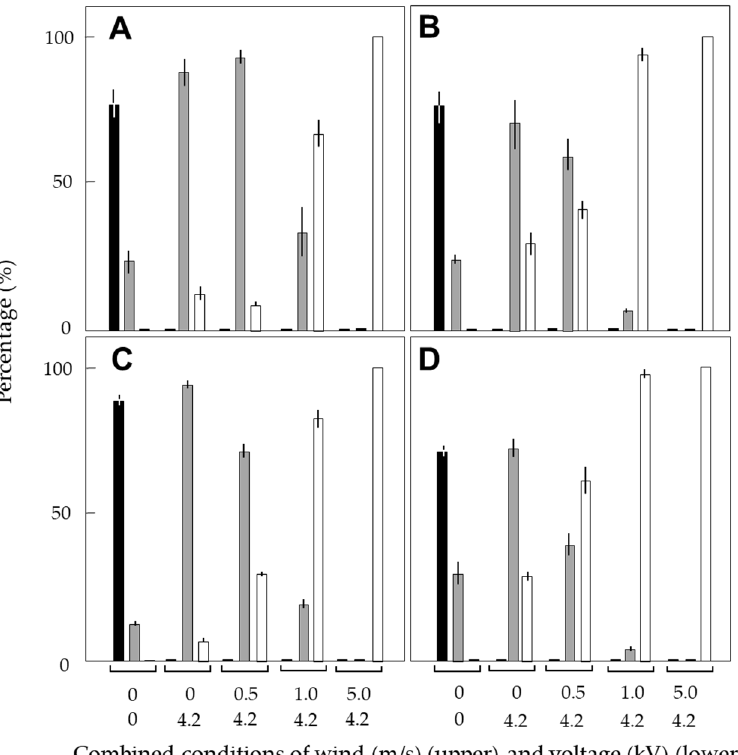
Figure 11. Behavior of adults of shore flies ( A ), western flower thrips ( B ), green peach aphids ( C ), and whiteflies ( D ) reaching the screen net under different wind speed and voltage conditions. Black, gray, and white columns represent insects passing through the screen, removed without entering the screen, and drawn to the NC-IC, respectively. We used 20 insects for each voltage. Data are means and standard deviations of three replications [6].